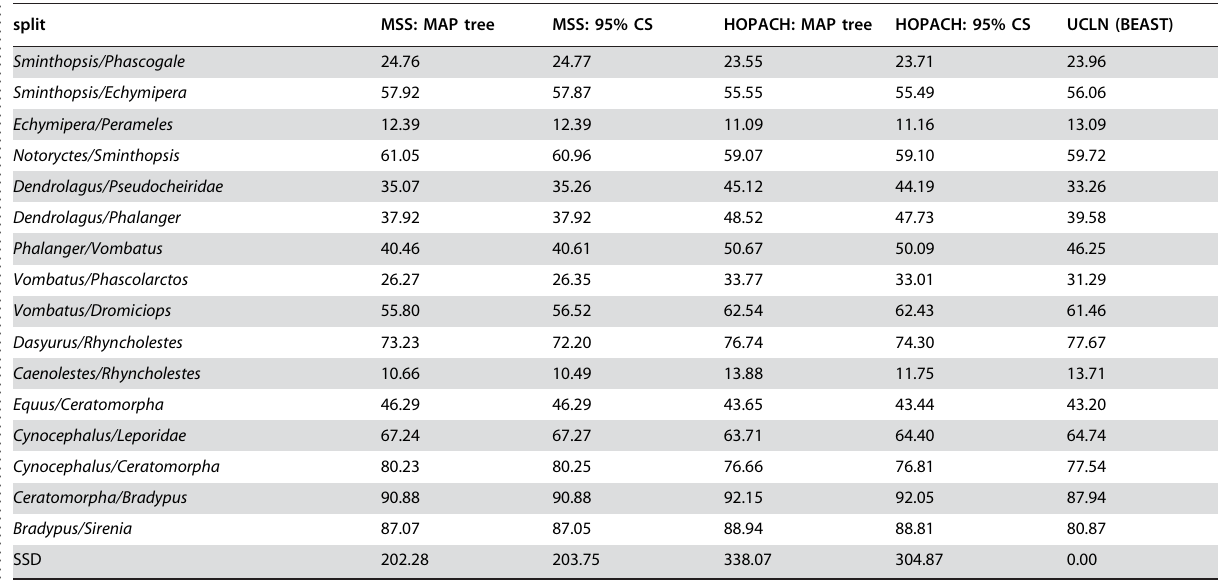
Table 3. Effect of neglecting phylogenetic uncertainty on estimates of divergence times under local clock models for the marsupial